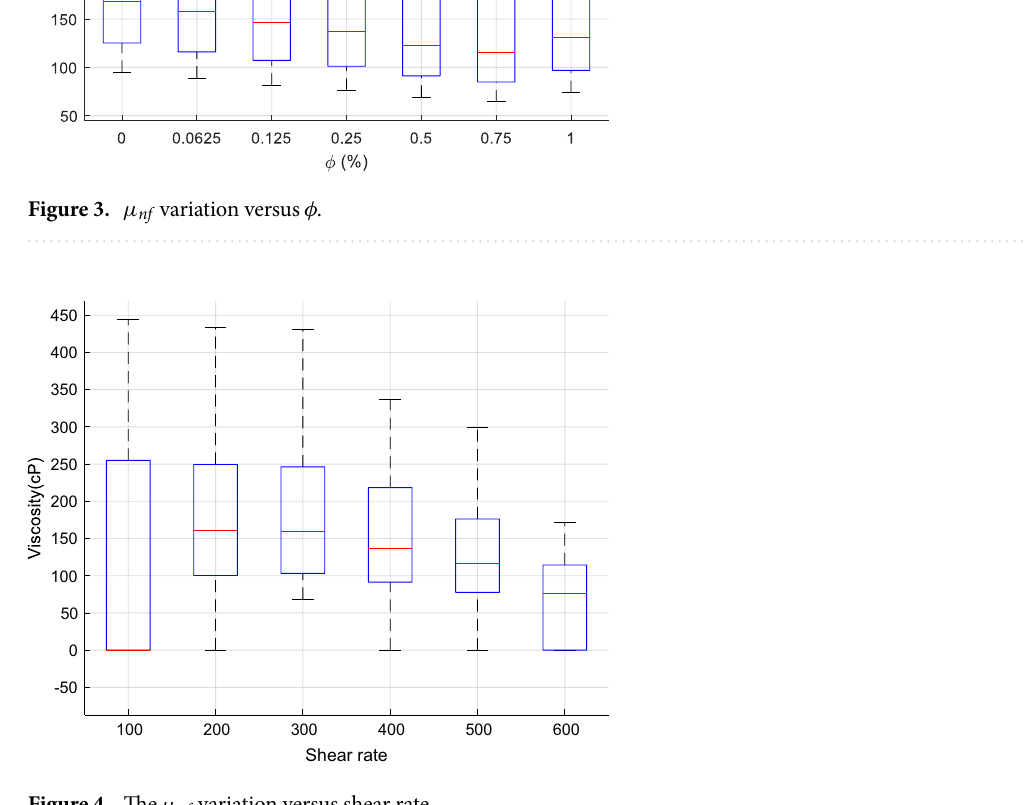
Figure 4. The µ nf variation versus shear rate.